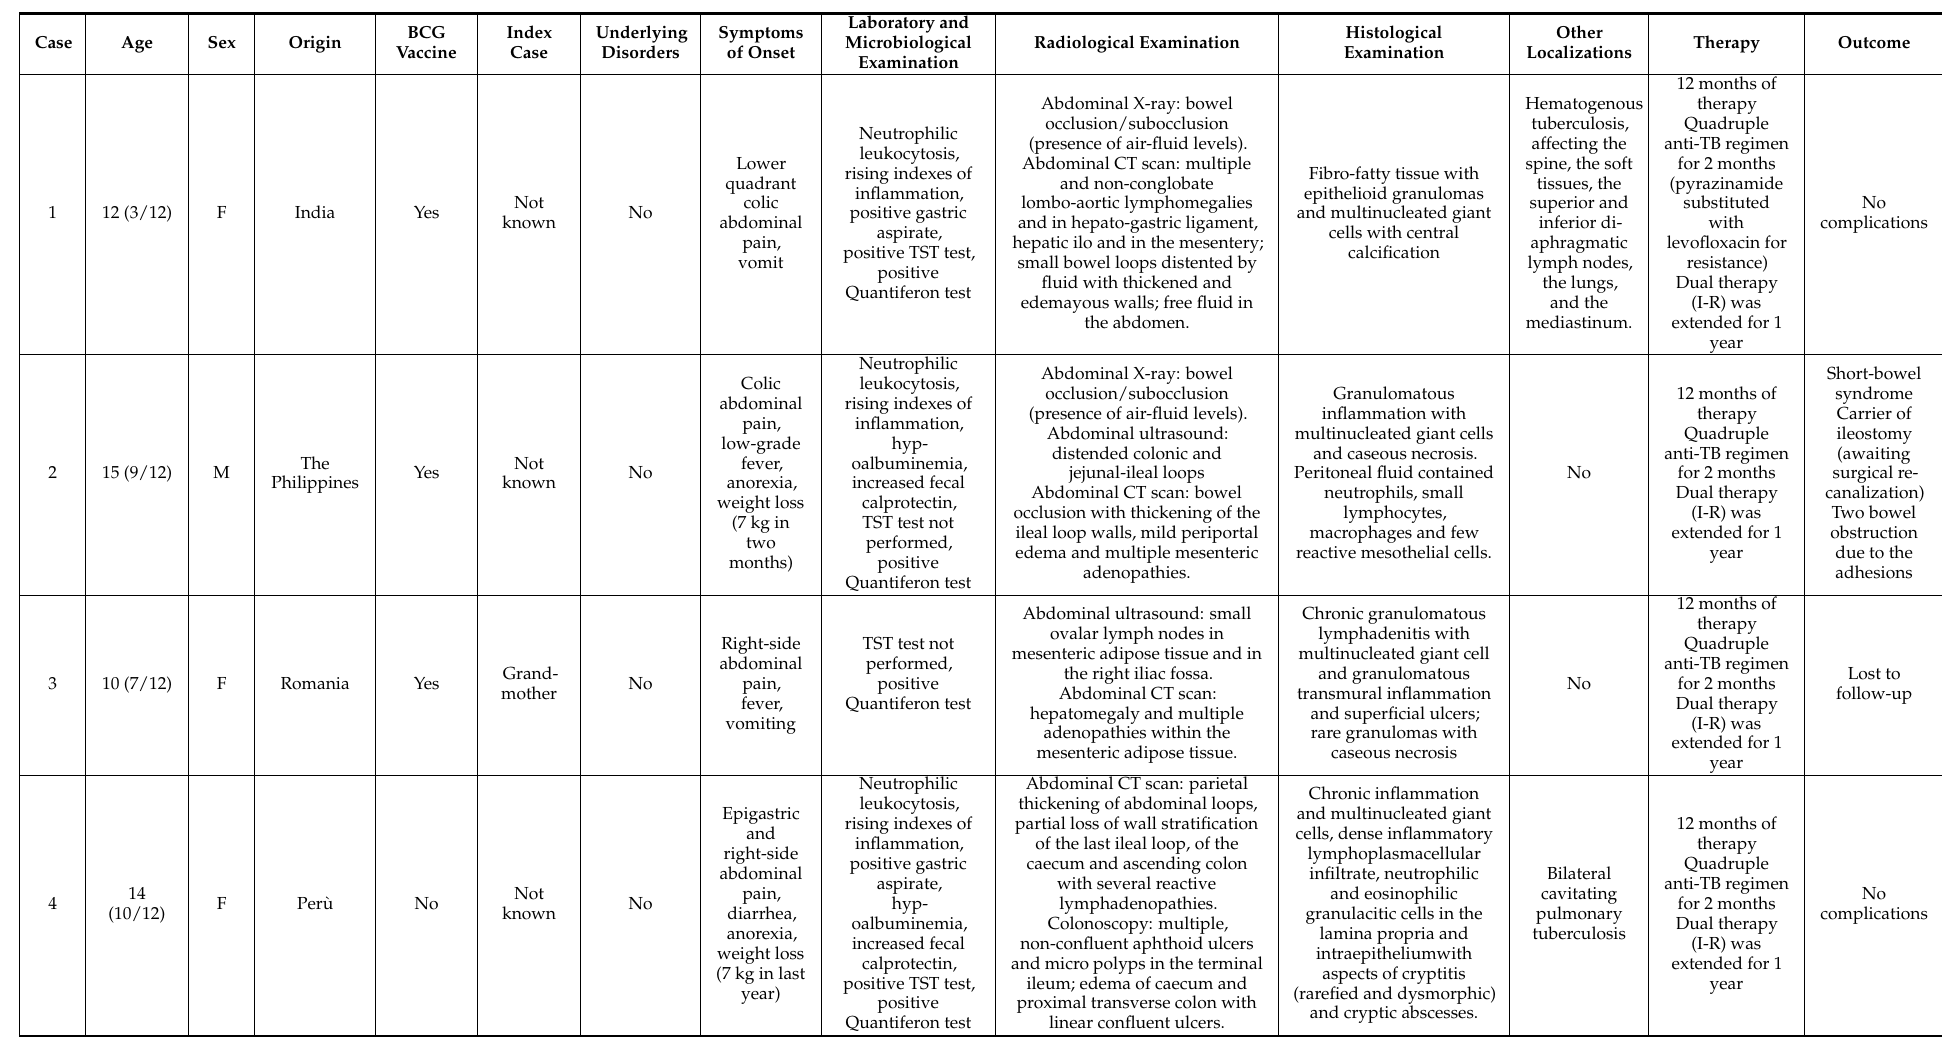
Table 1. Characteristics of abdominal tuberculosis (TB) in five